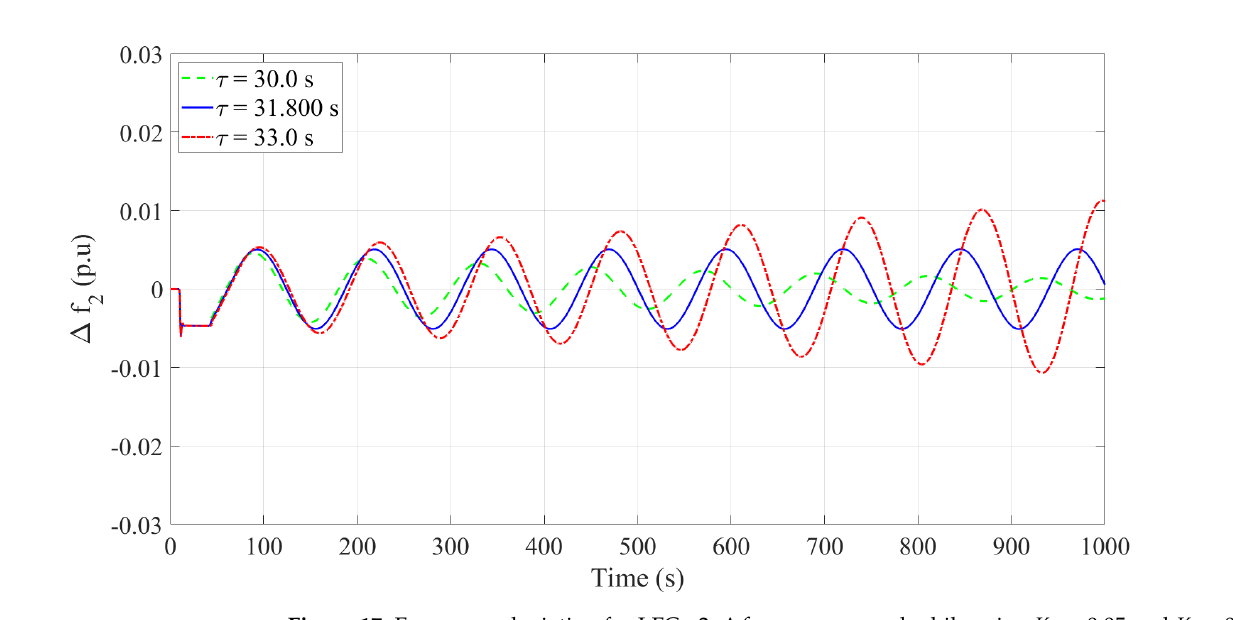
Figure 17. Frequency deviation for LFC − 2: ∆ f 2 was measured while using K P = 0.05 and K I = 0.05. Figures 16 and 17 depict the frequency response with time delay, τ , of 30.0 s, 31.800 s, and 33.0 s, for area 1 and area 2, respectively. It is obvious that the system is stable with τ = 30.0 s and unstable with τ = 33.0 s. Meanwhile, the system is marginally stable with τ = 31.800 s. The percentage inaccuracy while employing the simulation-based DM is 0.2987%. Figure 18 depicts the spectral radius against the frequency for K P = 0.05 and K I = 0.05. It was found that the crossing frequency, ω c , was equal to 0.05011 rad/s with